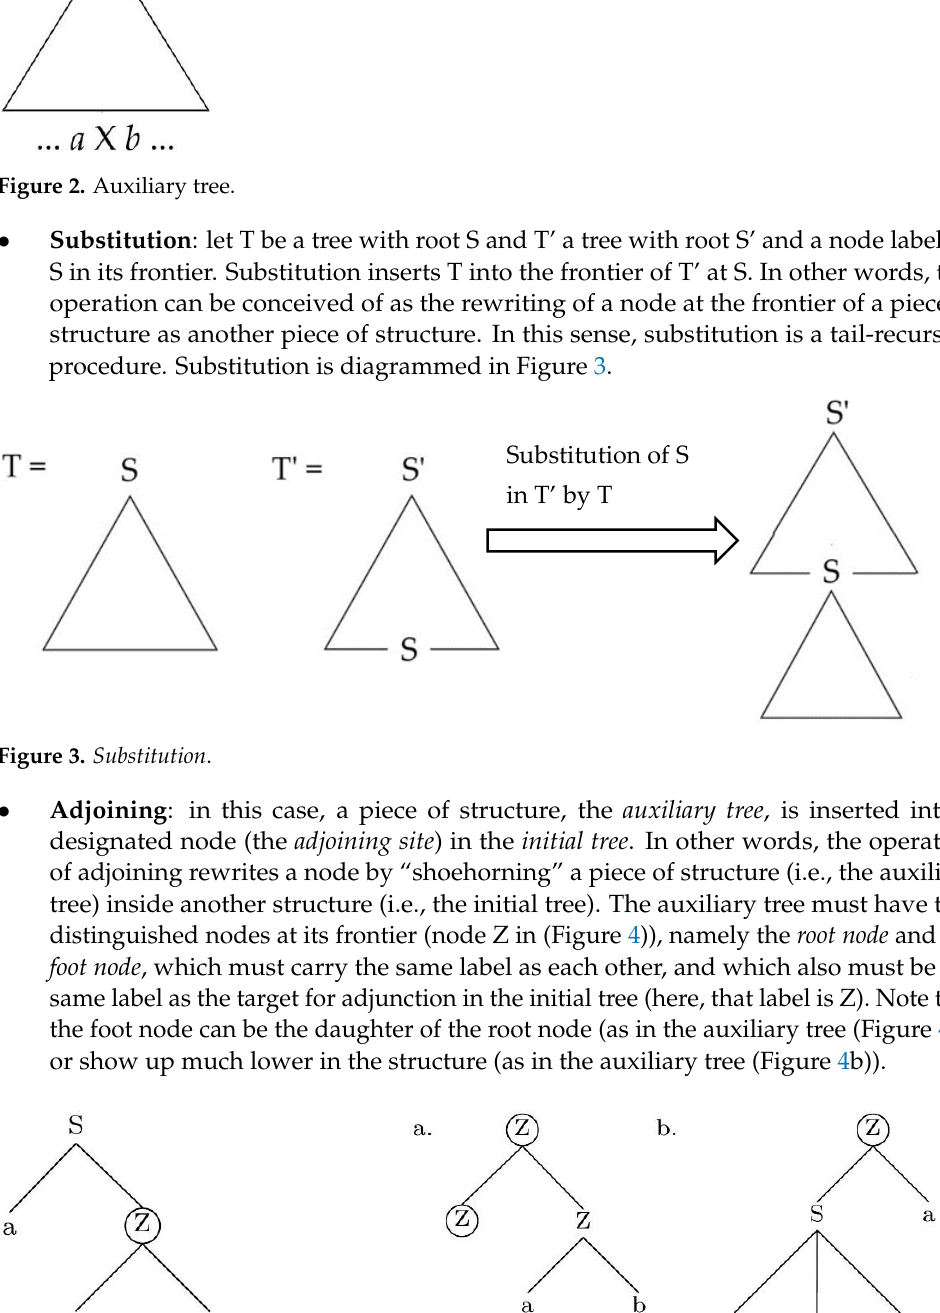
Figure 2. Auxiliary tree.